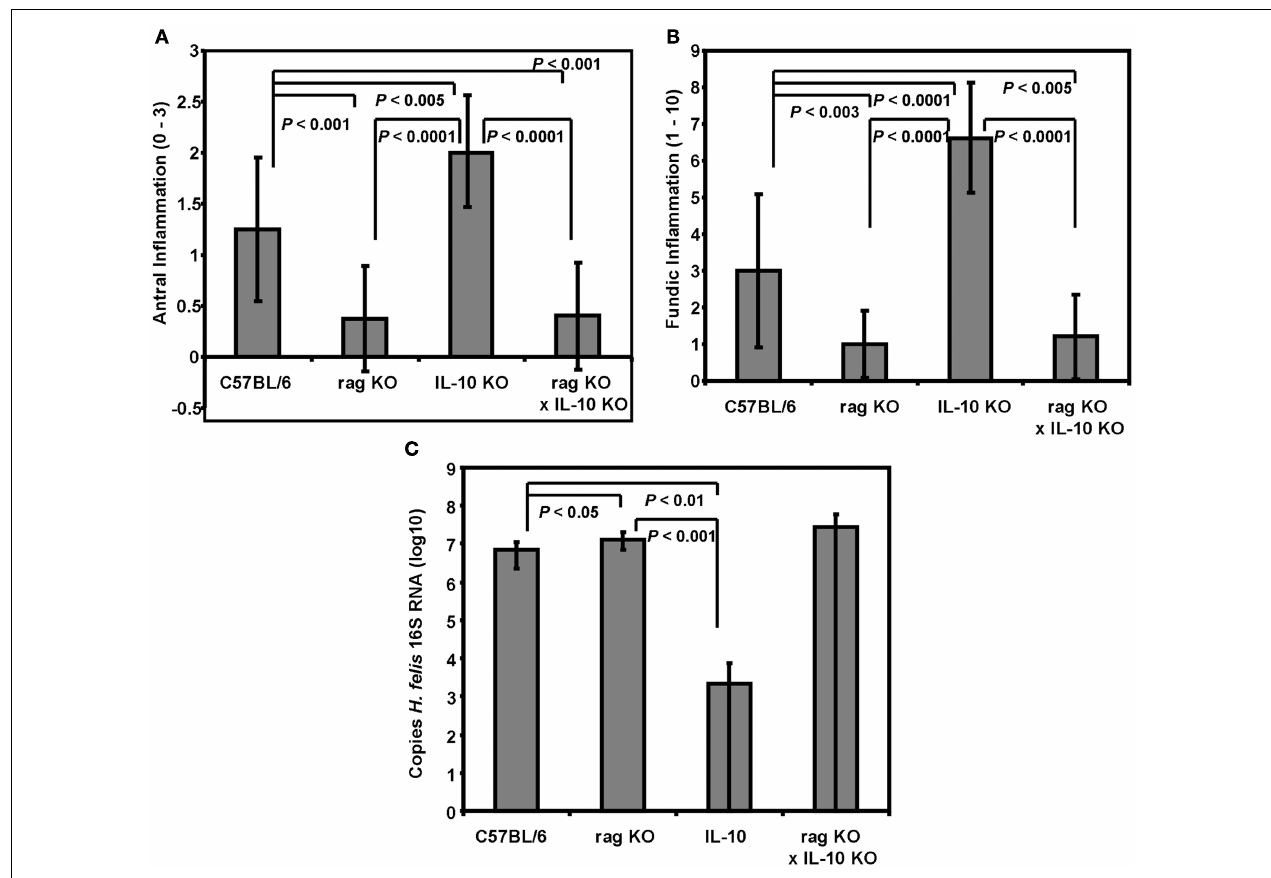
histologic grading of H&E stained longitudinal sections.The bacterial load per stomach was determined by quantitative PCR of the 16S RNA gene from a single strip biopsy encompassing the entire length of the gastric mucosa (C) . Data is reported as DNA copies per gram stomach tissue. N = 8–10 mice per